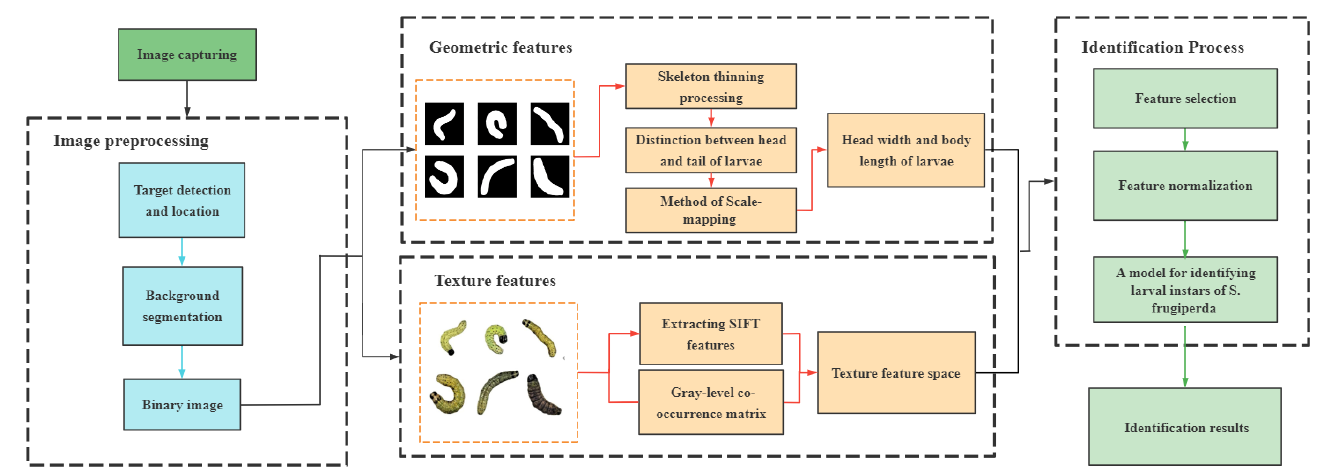
Figure 3. The architecture of FAW larval instar identification method.